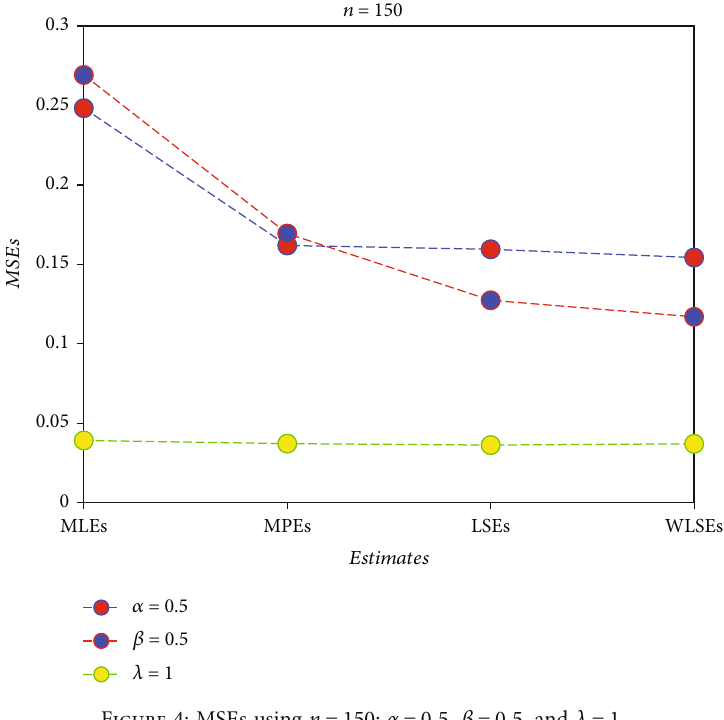
Figure 4: MSEs using n = 150 : α = 0 : 5 , β = 0 : 5 , and λ = 1 .